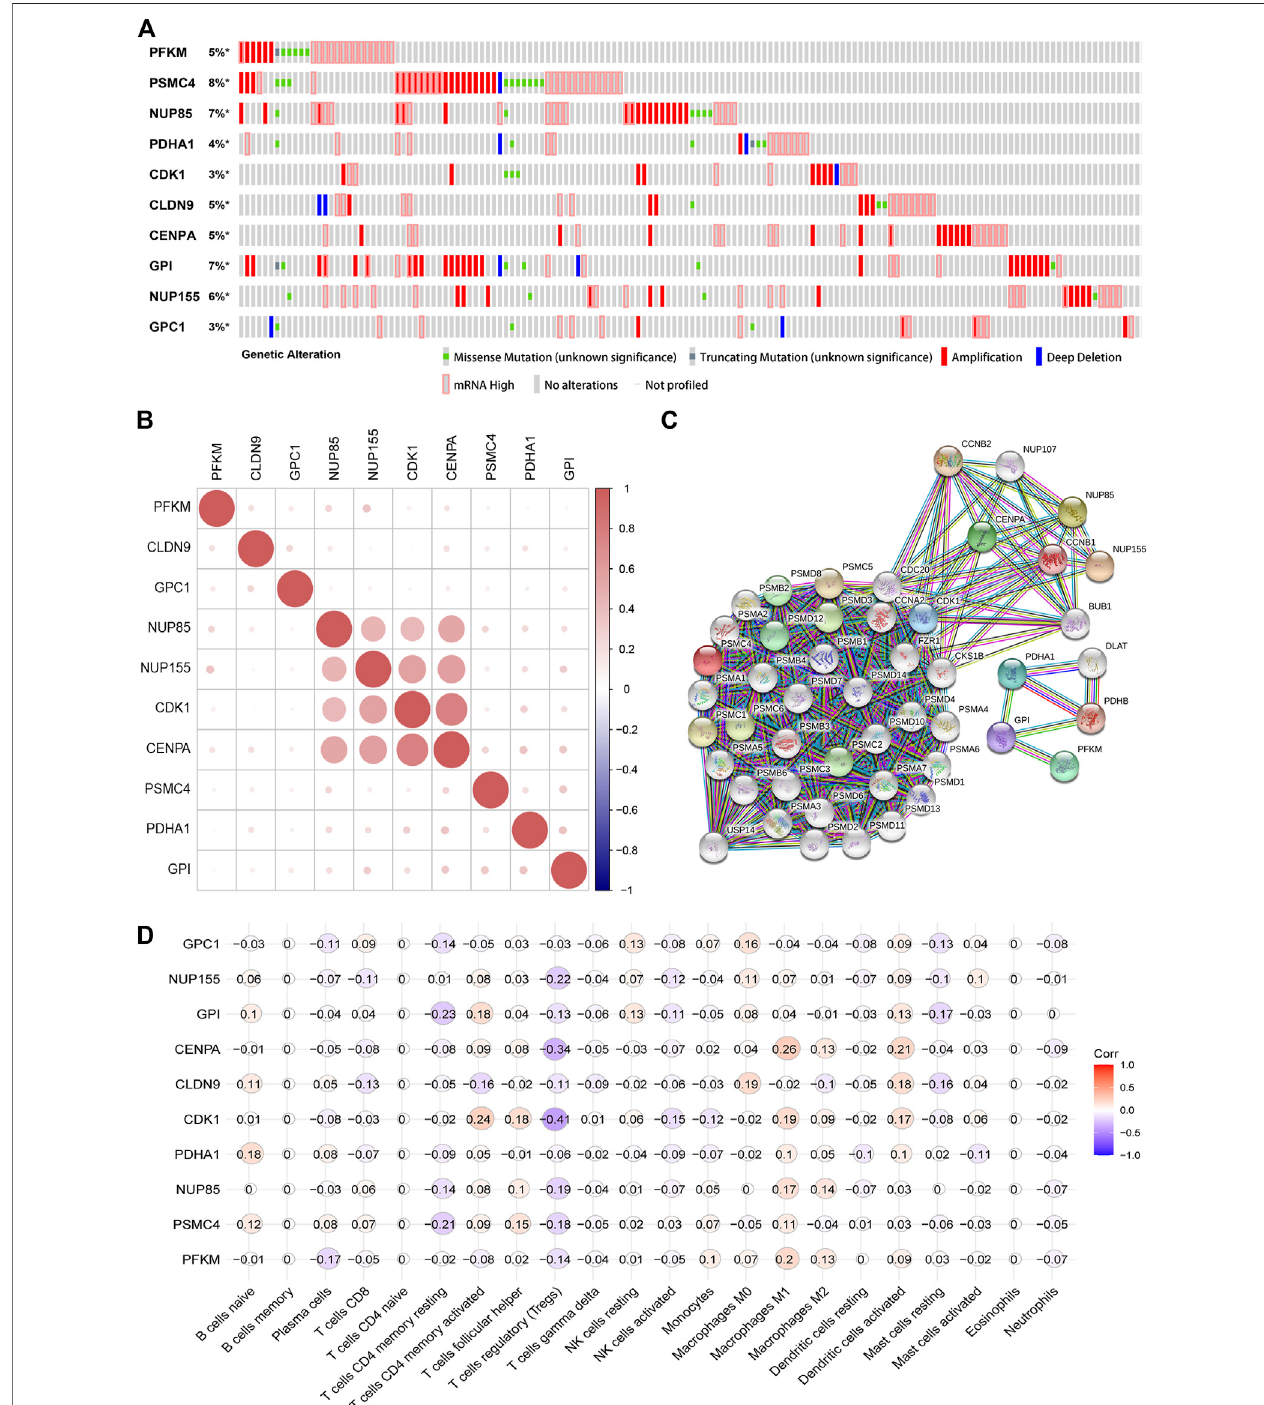
FIGURE8| Comprehensiveanalysisofglycolysis related genesinthegenesignature (A) .Genealteration ofselectedgenesinpatientswithEC fromthecBioPortal website (B) . Co-expression analyses of 10 glycolysis-related gene signatures in EC by the R “ corrplot ” package (C) . Protein-protein interaction network of 10 gene signatures and other closely related proteins (D) . Correlation between the 10 glycolysis-related gene signatures and various immune cells. Red represents a positive correlation, and blue represents a negative correlation.